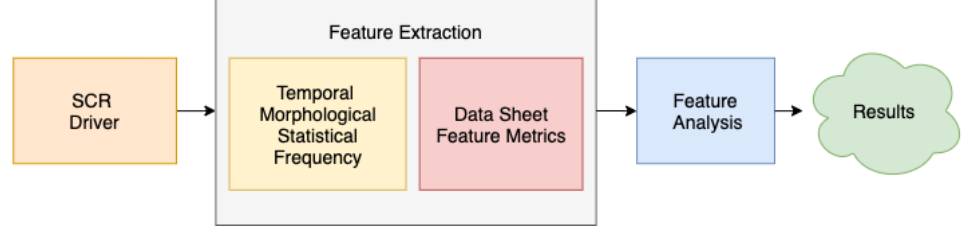
Figure 3. Flowchart of the feature extraction